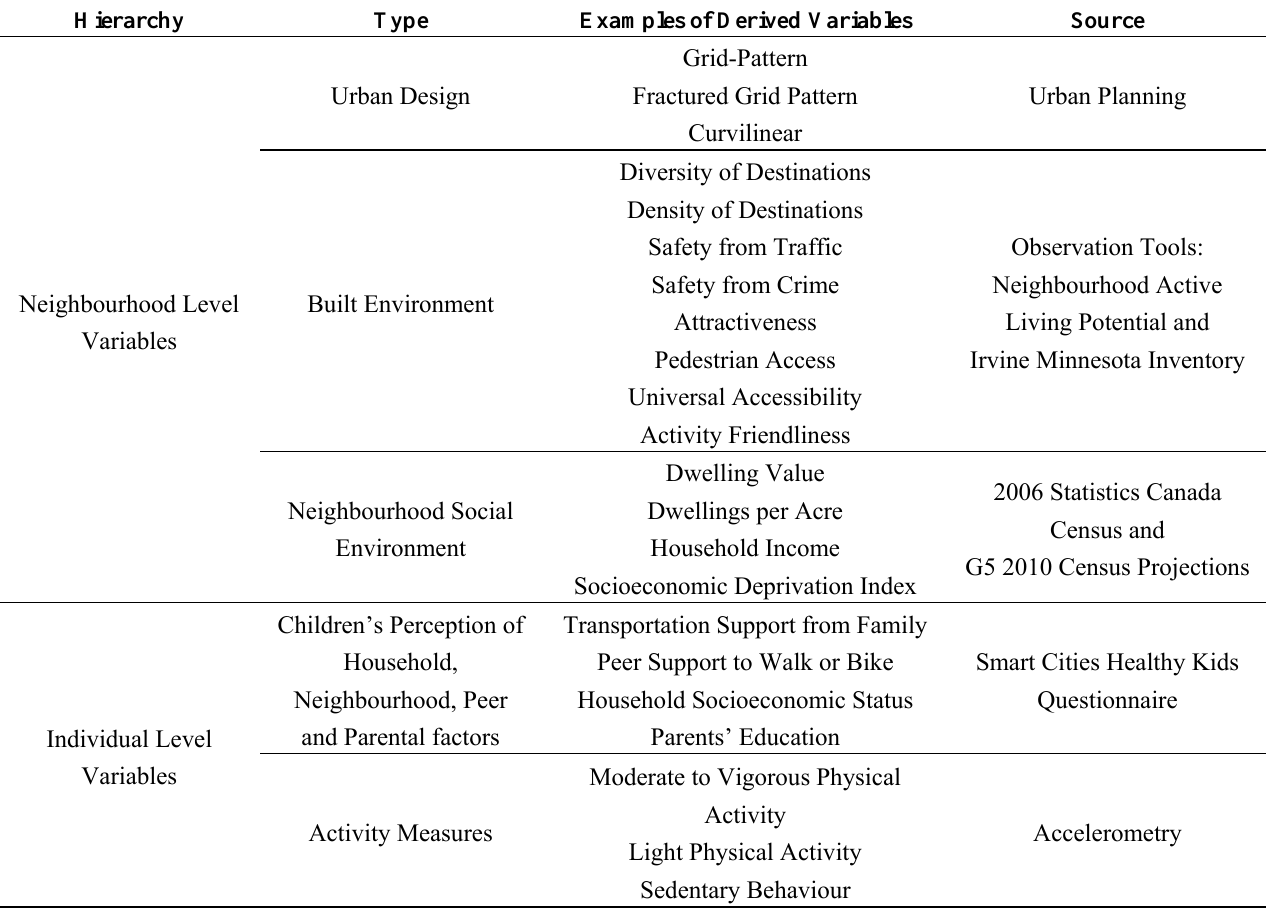
Table 1. Hierarchical classification of derived predictors.